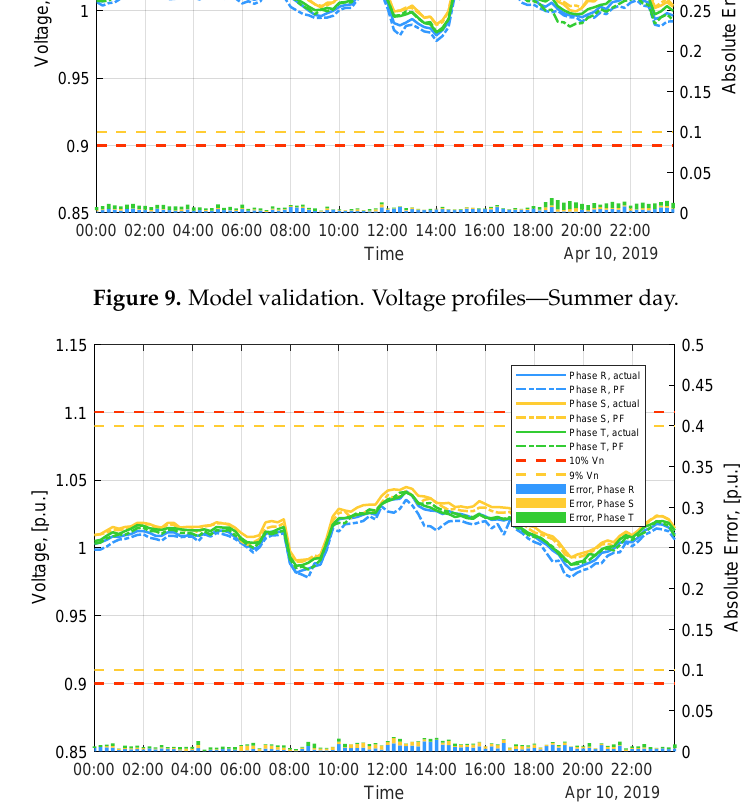
Figure 10. Model validation. Voltage profiles—Autumn